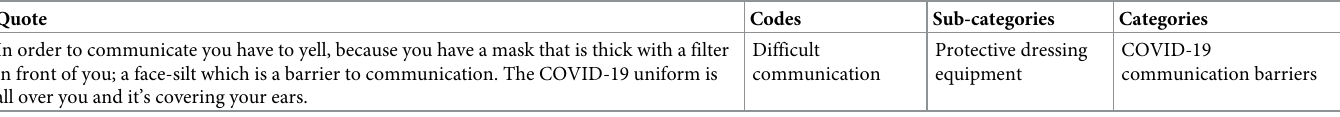
Table 1. Example of the process of analysis from quote to category. Quote